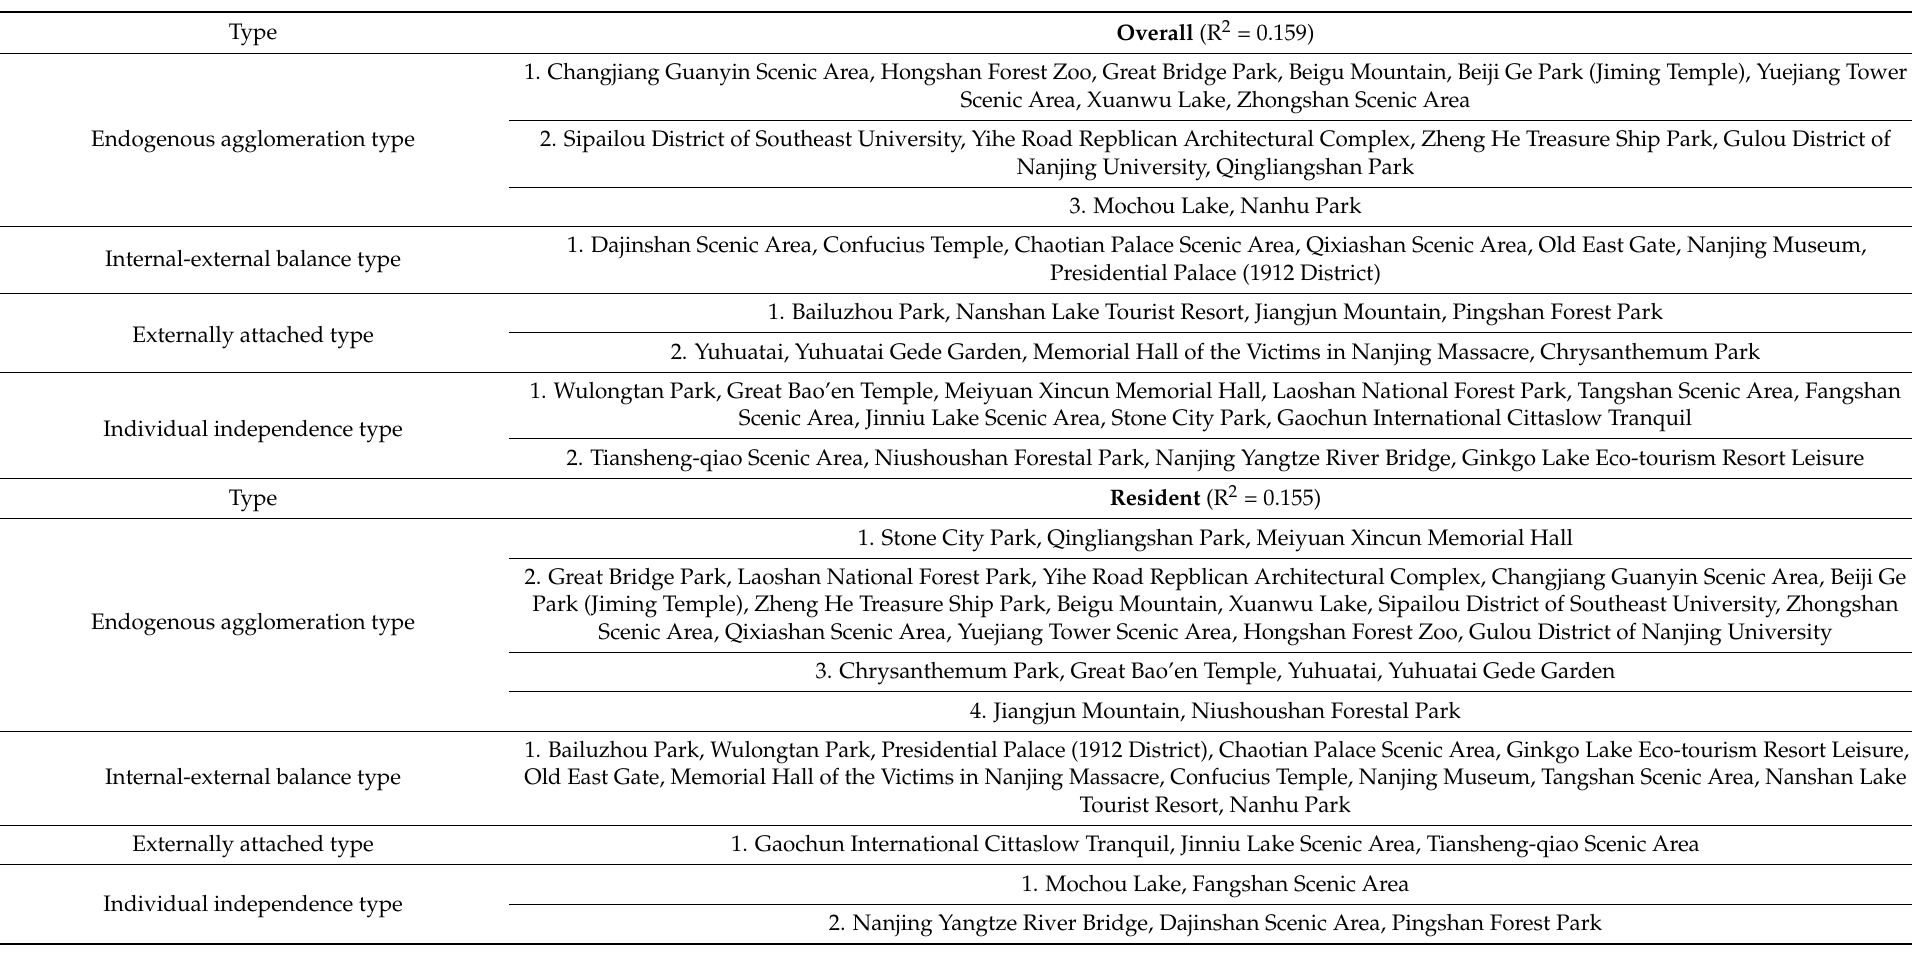
Table 4. Cohesive subgroups of tourism flow networks under three types of network